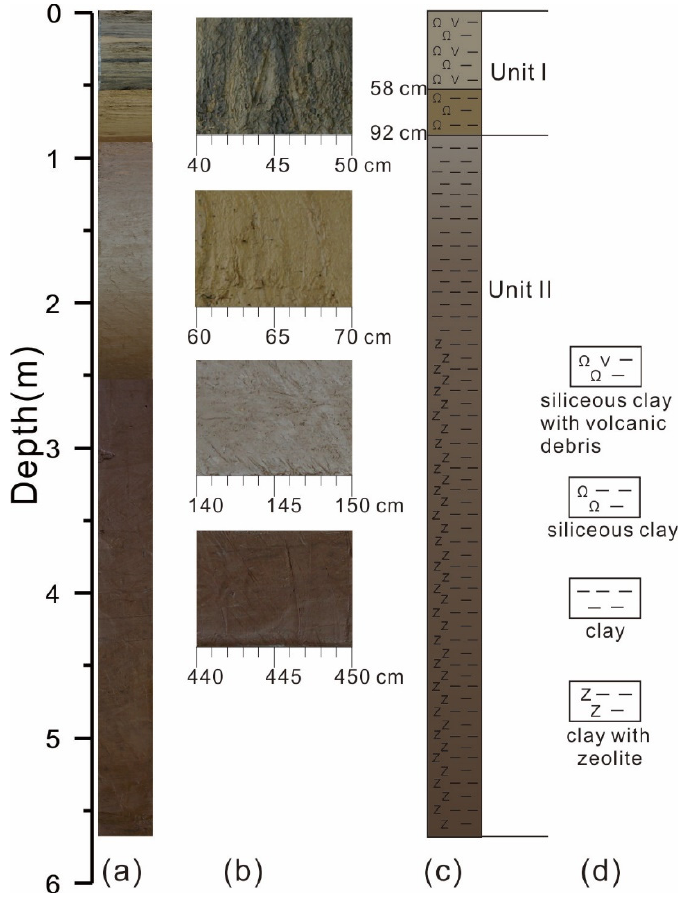
Figure 2. Photography ( a , b ) and lithological changes ( c ) of core PC15; ( d ) lithological